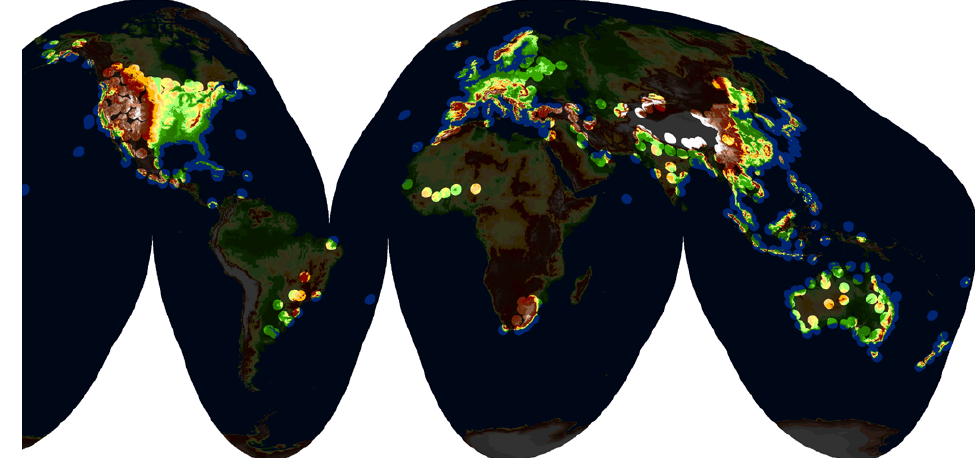
Fig. 1. Current weather radar coverage provided by national weather services (in Goode Homolosine projection). For computing the area illuminated by terrestrial weather radars, we assumed a maximum range of 200km per radar device. The underlying database was established based on a web search of national weather services’ web pages, web documents, and the WMO radar database http://wwr.dmi.gov.tr (which is quite incomplete, though, in comparison to the results shown in this figure). The sources of information are listed in the Supplement Sect. 1. The figure shows that almost complete coverage is achieved for North and Central America, as well as Western and Central Europe. Good coverage is also available for the Middle East, South, Southeast and East Asia, and Australia. Large parts of Africa and South America remain uncovered, yet, as well as vast parts of Russia (although a new network with about 140 Doppler radars is planned to be established in Russia by